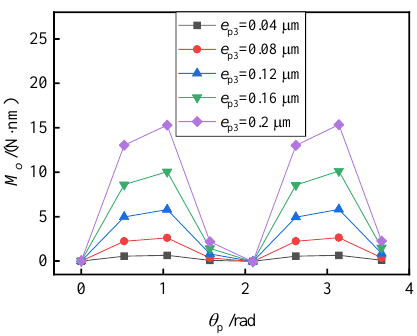
Figure 13. Interference torque versus trigone error.